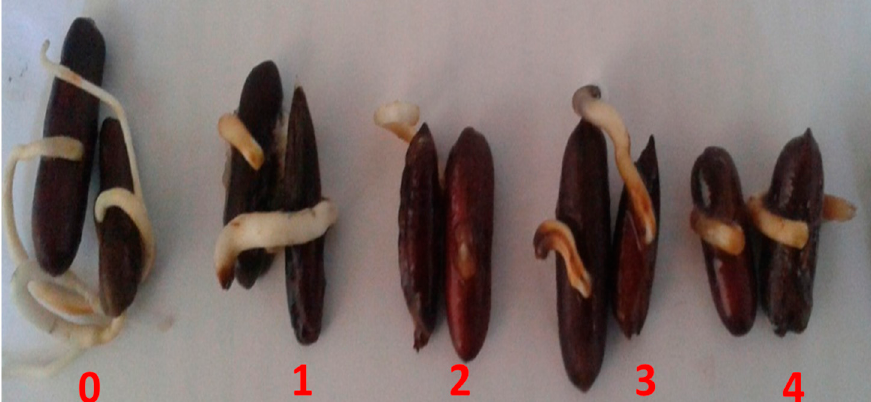
Figure 3. Symptoms of root rot disease caused by four isolates of F. oxysporum on germinated seeds of date palm. Healthy (uninfected) germinated seeds ( 0 ), necrotic radicals infected with F. oxysporum ( 1 – 4 ) showing different degrees of rot and brown discoloration.